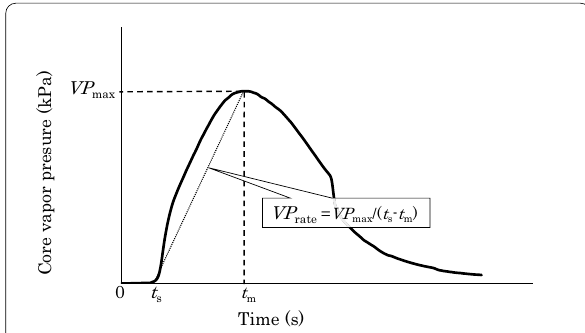
Fig. 5 Representative vapor pressure–time curve in the mat core with the indices: VP max , t s , t m , and, VP rate defined in Table